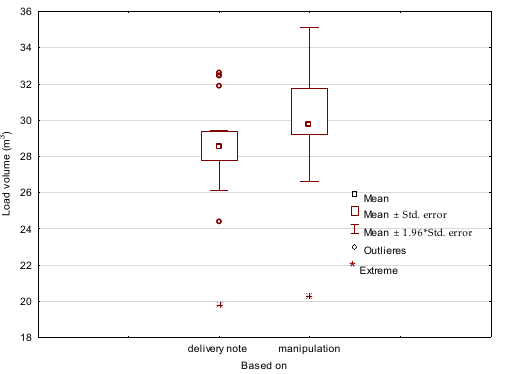
Figure 7. Characteristics of wood loads by delivery note and measurement using laser scanning.